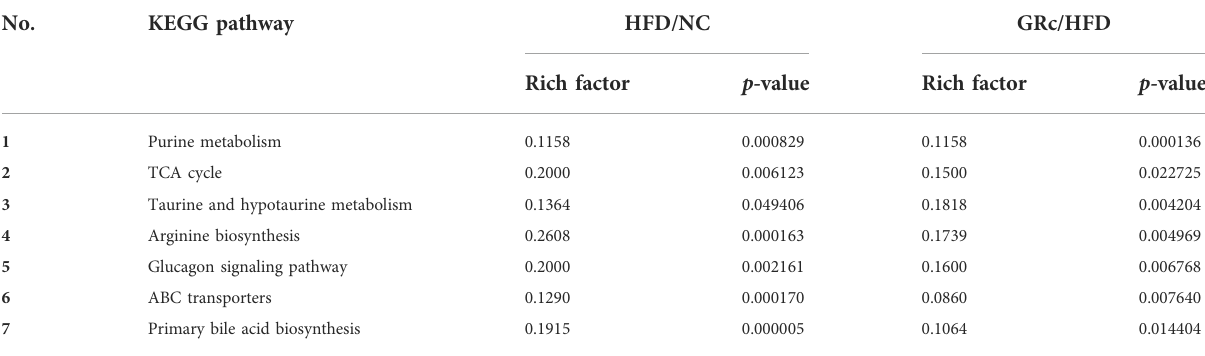
TABLE 1 Potential metabolite pathway regulated by GRc in the AS